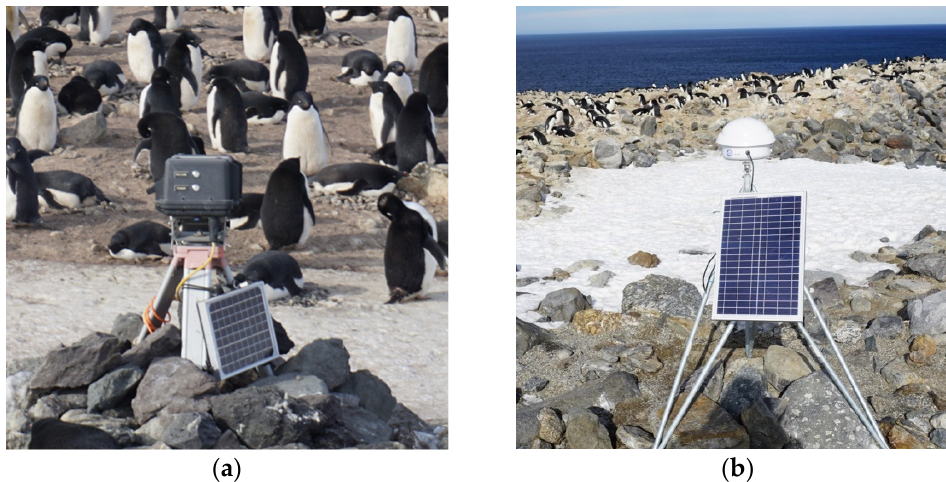
Figure 4. Remotely operated time-lapse cameras: ( a ) the Penguin Nest Camera at Edmonson Point, ( b ) Cyclapse Harbotronics at Adélie Cove (photo silviaolmastroni@PNRA2017).